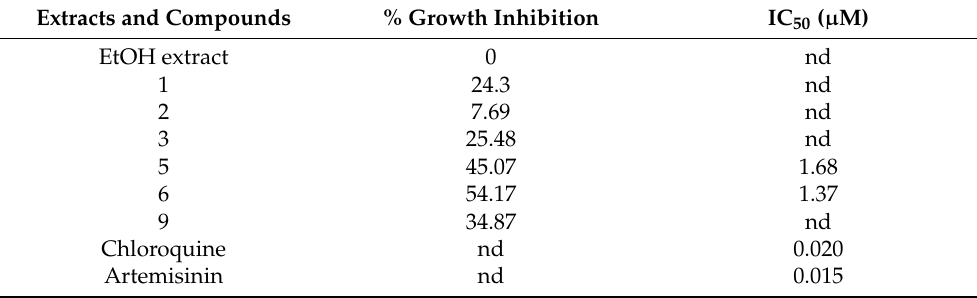
Table 3. Antiplasmodial activity of extracts and some isolated compounds. Extracts and Compounds % Growth